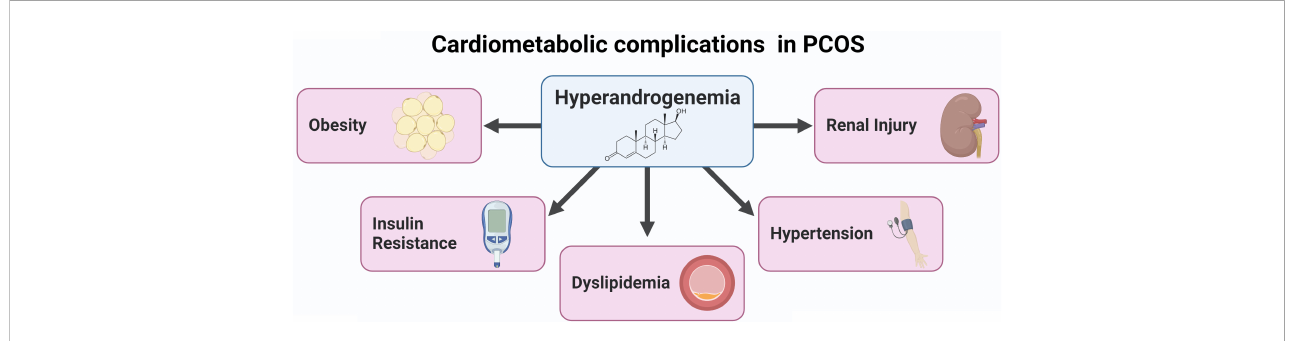
FIGURE 2 Cardiometabolic complications in